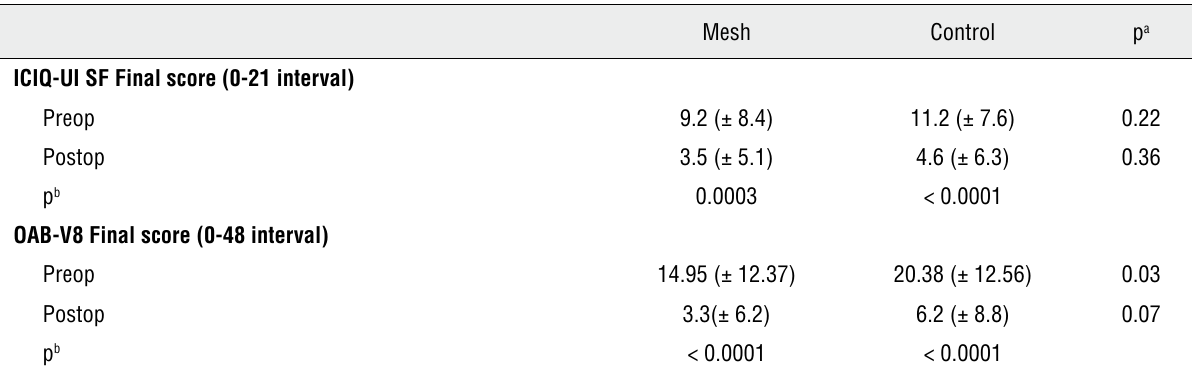
Table 3 - Evaluation of final scores of ICIq-uI SF and OAB-V8 questionnaires at the pre- and postoperatory periods of patients from Mesh and Control groups. Values presented as mean ± SD.